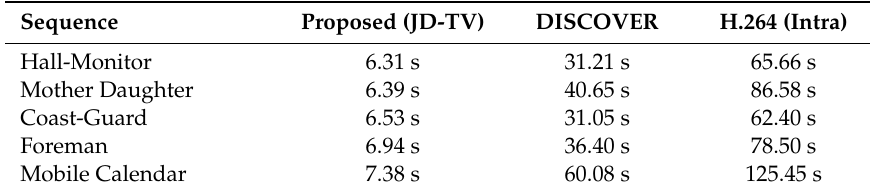
Table 9. Average encoding (execution) time (sec) comparison of proposed CS based JD-TV codec with conventional video codecs (DISCOVER, H.264 (intra)) for various video sequences. Sequence